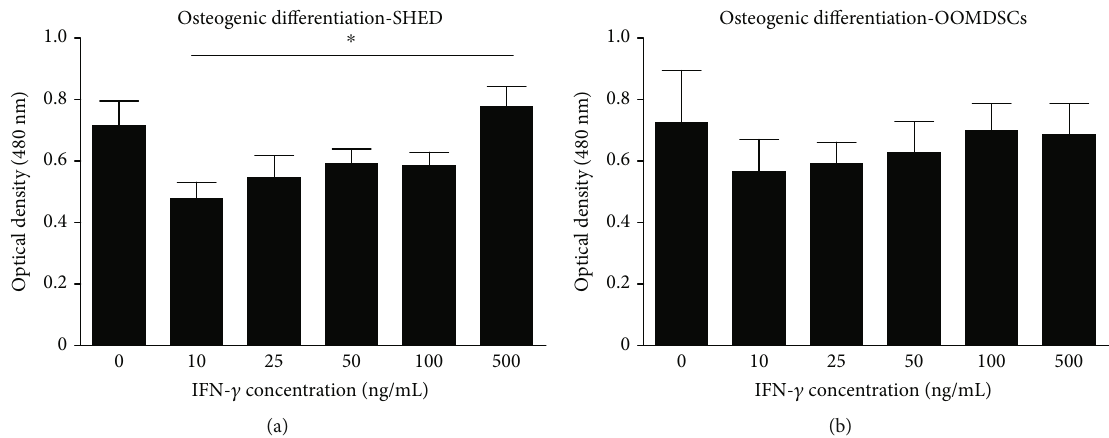
Figure 2: E ff ects of proin fl ammatory stimulation with IFN- γ on the osteogenic di ff erentiation potential of SHED and OOMDSCs. (a, b) The addition of IFN- γ at a concentration of 10 ng/mL, 25 ng/mL, 50ng/mL, 100ng/mL, or 500ng/mL maintained the osteogenic di ff erentiation potential of both SHED (a) and OOMDSCs (b) at levels similar to the level observed with control treatment. A statistically signi fi cant di ff erence was observed only between SHED maintained in osteogenic di ff erentiation medium supplemented with IFN- γ at a concentration of 500 ng/mL ( 0 : 77 ± 0 : 06 sd) and SHED cultured in osteogenic di ff erentiation medium supplemented with IFN- γ at a concentration of 10 ng/mL ( 0 : 47 ± 0 : 06 sd). ∗ p < 0 : 05 , determined by one-way ANOVA followed by the Bonferroni post hoc test. Five experimental replicates were performed for each group for both SHED and